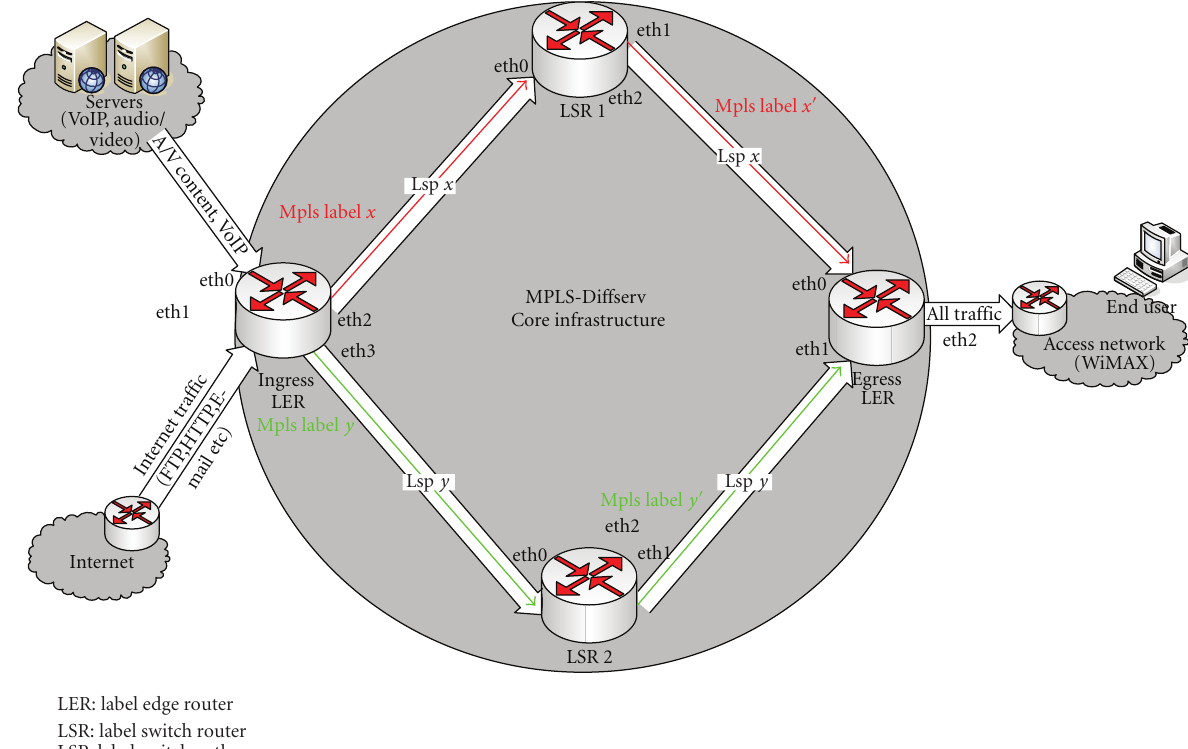
Figure 5: MPLS-Di ff Serv-WiMAX experimental